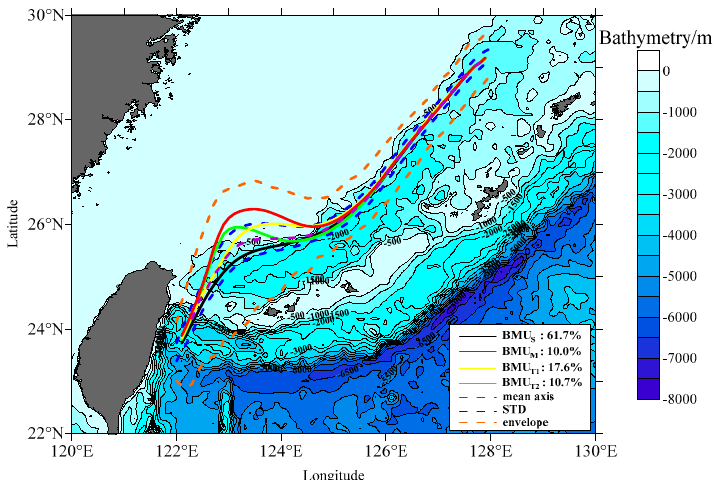
Figure 9. Self-organizing map analysis of the Kuroshio axis northeast of Taiwan Island. BMU S , BMU M , BMU T1 , and BMU T2 represent the derived four patterns. The numbers are corresponding index of the occurrence frequency for each pattern. The mean, STD, and envelope axes are indicated by purple, blue, and orange dashed curves, respectively. The color-filled contours indicate the bathymetry.